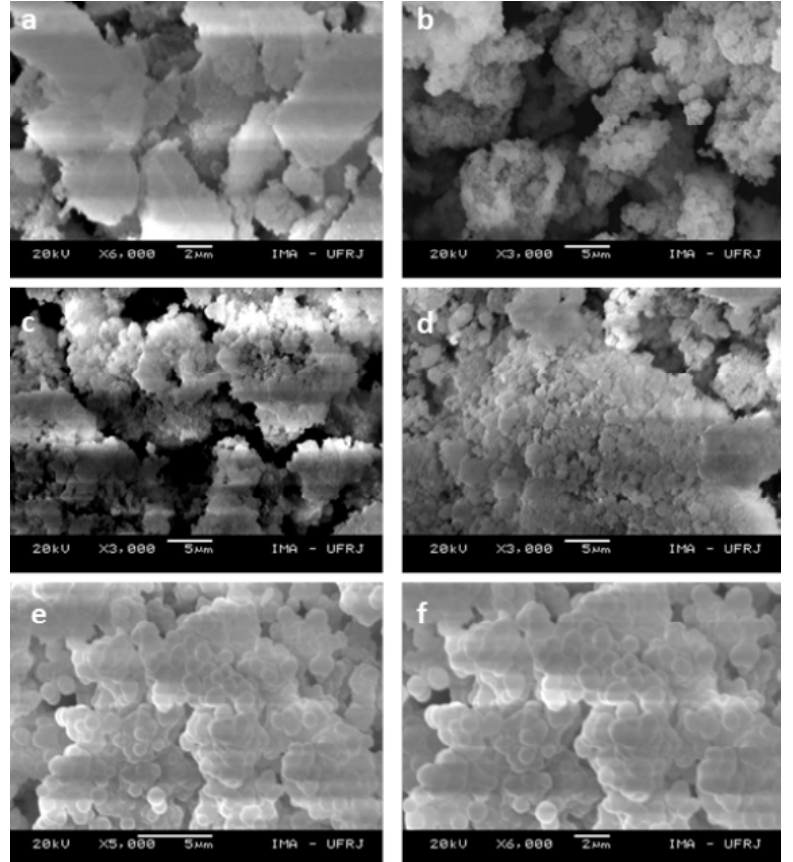
Fig. 5. SEM images of (a, b) SiO f) SiO -Mag-IBU at X3000 and X6000 respectively. 2